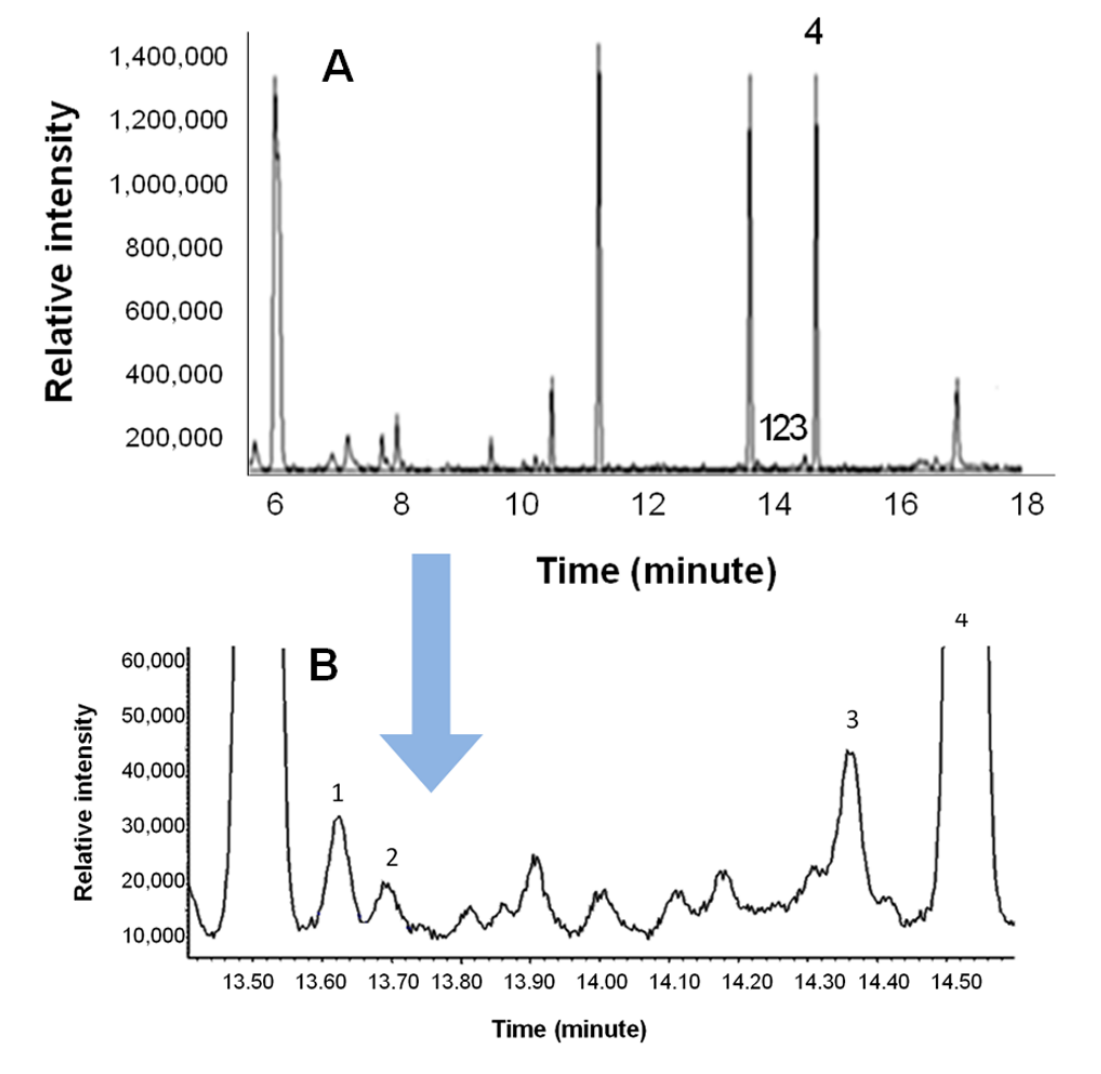
Figure 2. ( A ) Total ion chromatogram of H. scabiosae eggs, analyzed by an Agilent 6890 N GC instrument. Peaks of choice are numbered based on their elution time. ( B ) The same chromatogram, zoomed at RT 13:40- 14:60. 1: palasoninimide (RT 13:62), 2: palasonin (RT 13:69), 3: cantharidinimide (RT 14:34), 4: cantharidin (RT 14:53). RT: retention time